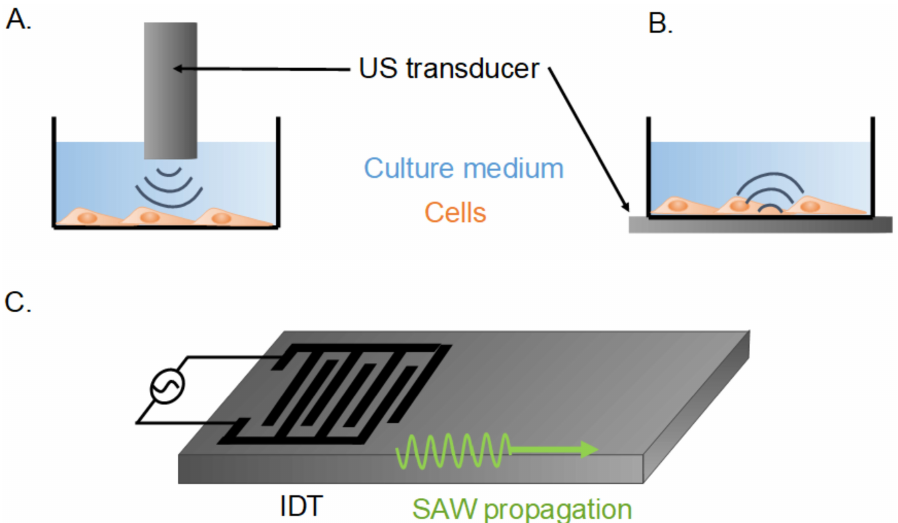
Figure 1. Schematic view of cell-stimulation systems of low- or high-intensity ultrasound stimulation. ( A ): Cells stimulated mainly by the shear flow induced by a US transducer immersed in the culture well. ( B ): Cells stimulated mainly by the mechanical vibrations of the culture well. US stimulated by the US transducer under it. ( C ): Piezo-electric system with an interdigital transducer (IDT) inducing surface acoustic waves (SAW).